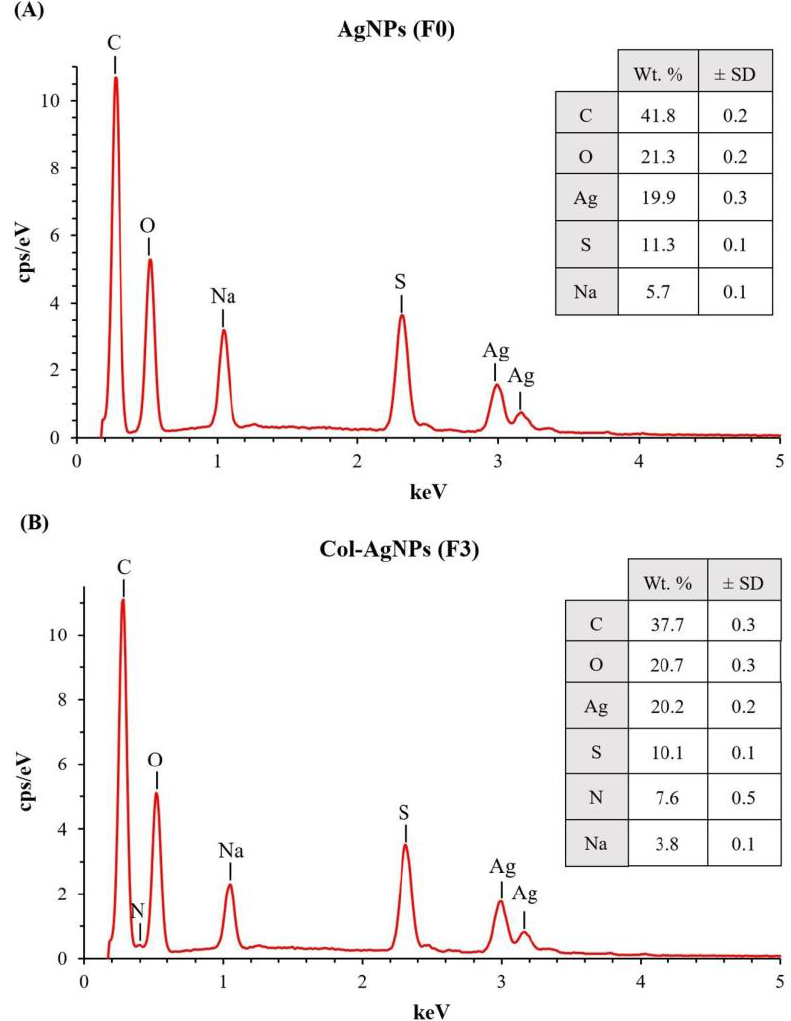
Figure 4. EDX spectrum of nanoparticles. ( A ) AgNPs in F0, and ( B ) Col-AgNPs in F3 .